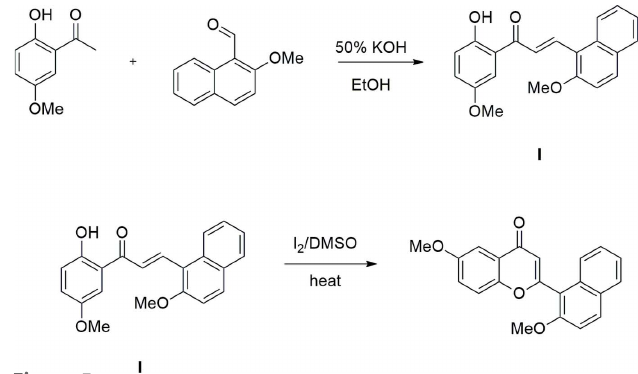
Figure 5 A synthetic scheme for the preparation of the title